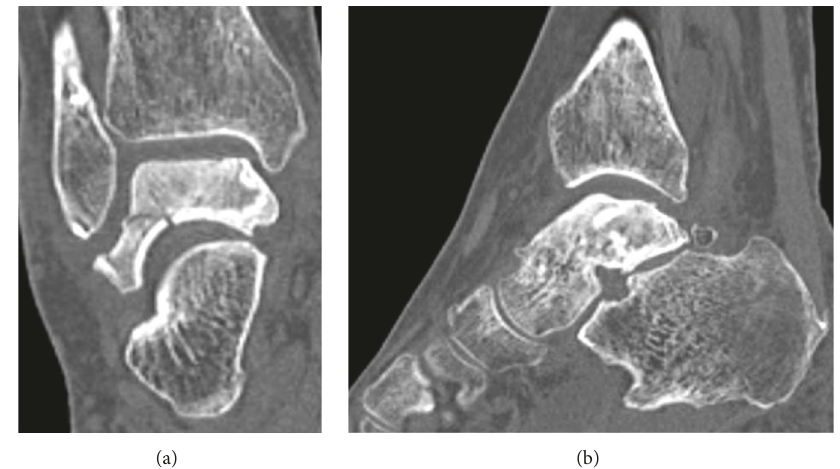
Figure 2: Preoperative CT scans showing sclerotic change and collapse of the talar body in coronal (a) and sagittal (b)